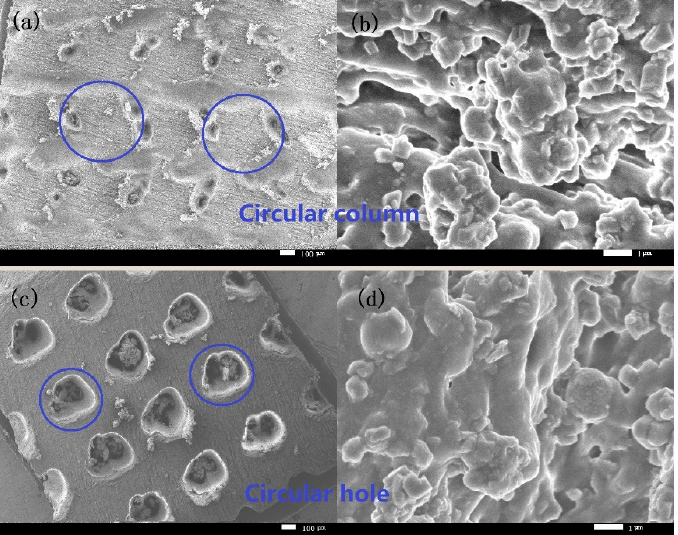
Figure 9. SEM images of ( a , b ) circular column and ( c , d ) circular hole texture surfaces after 100 abrasion cycles.